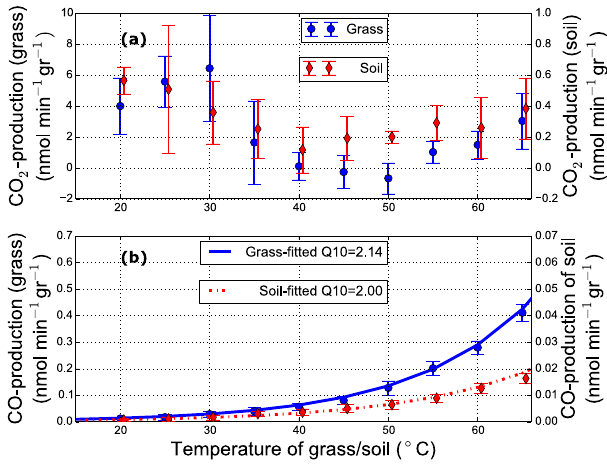
Figure 6. (a) Average CO 2 production of grass and soil material (nmolmin − 1 gr − 1 ) over different temperatures in the laboratory ex- periment; (b) average CO production of grass and soil material (nmolmin − 1 gr − 1 ) over different temperatures in the laboratory ex- periment, with fitted Q 10